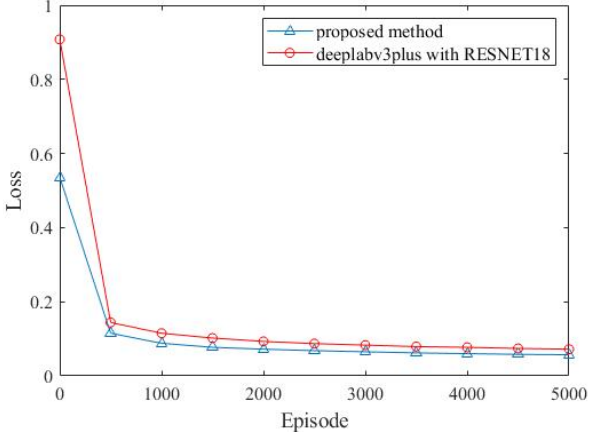
Figure 7. The loss values of different networks on the CULane train set. “Loss” denotes the 𝐿𝑜𝑠𝑠 𝑠𝑒𝑔 .